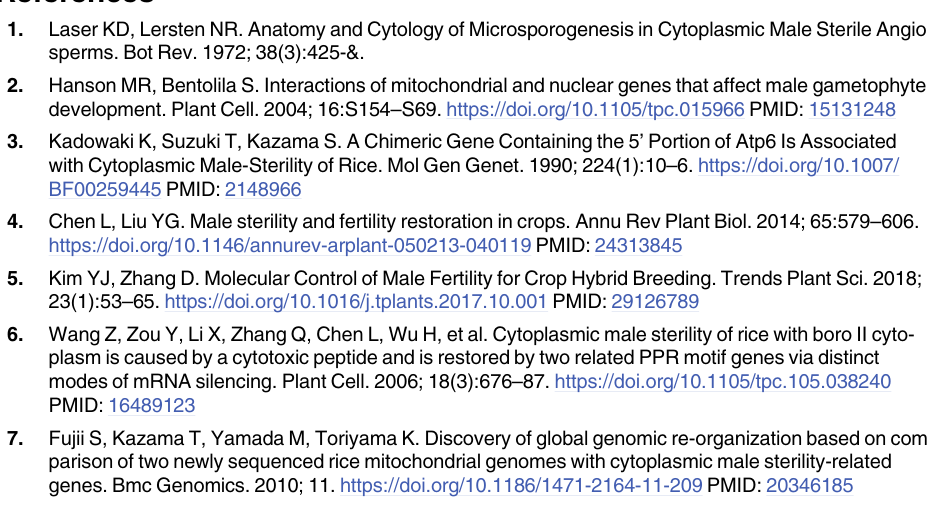
S4 Table. Summary of genome assemblies. S5 Table. List of accessions possessing both type 1 genotype and orf312